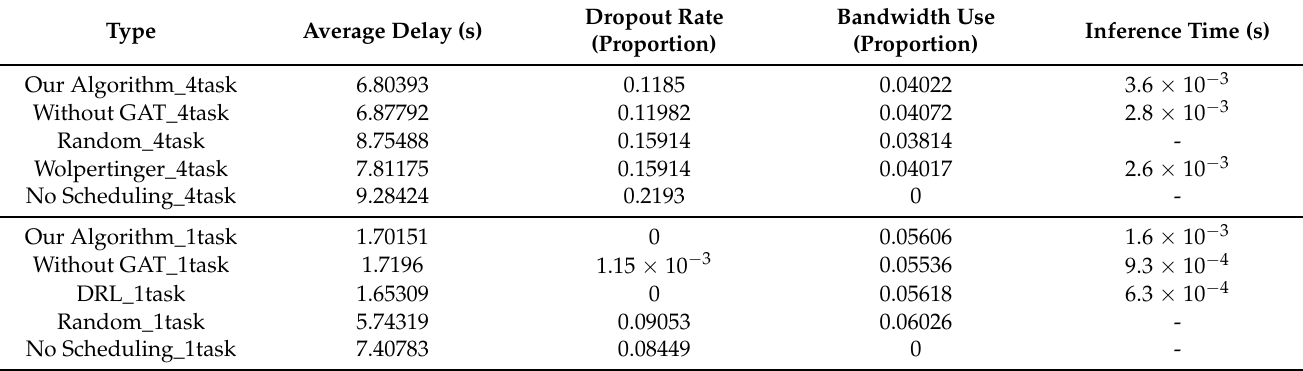
Table 2. Performance comparison under various